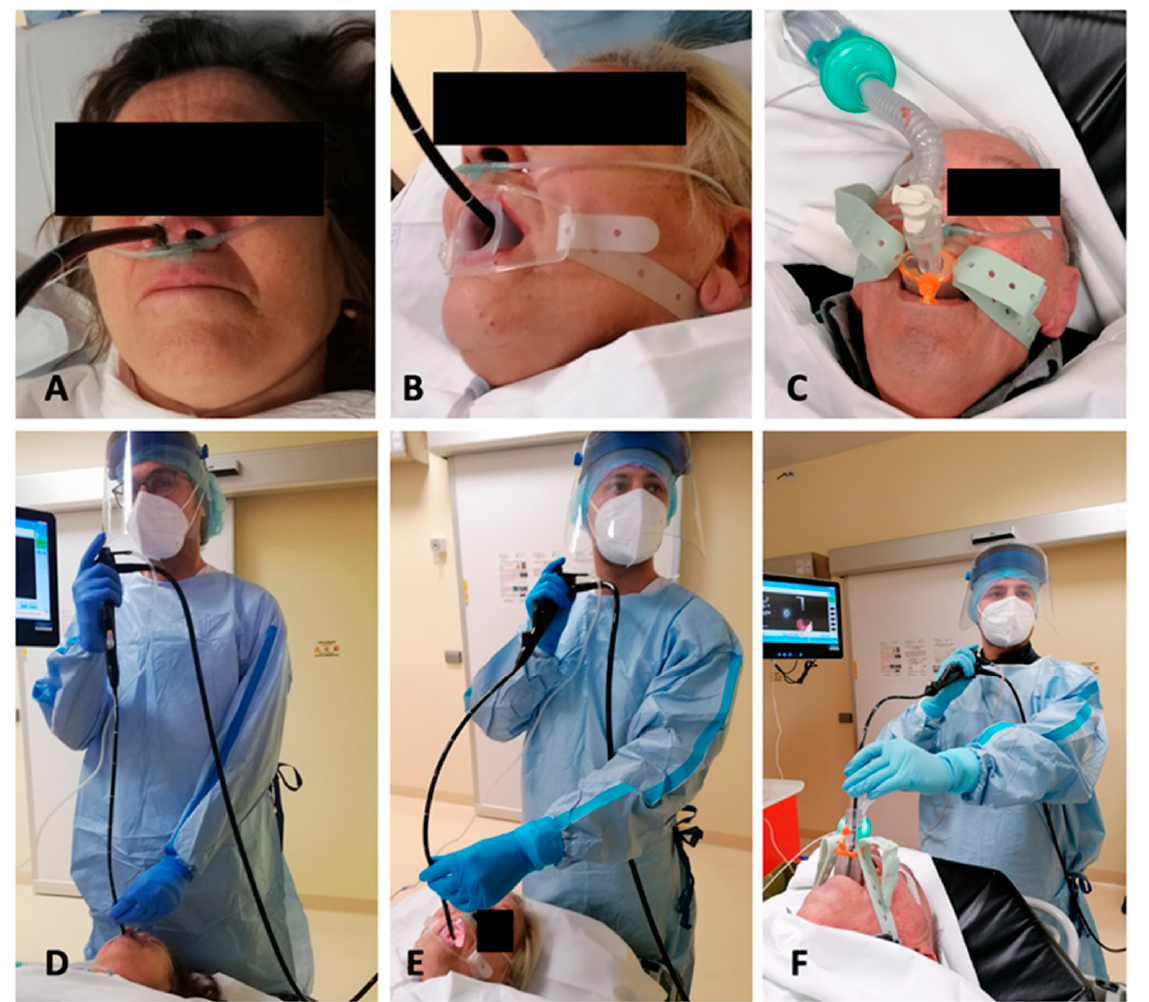
Figure 1. ( A – C ), entry ways of the EBUS scope: ( A ), nose; ( B ), mouth with mouthpiece; ( C ), laryngeal mask (i-gel). ( D – F ), endoscopist position in each of the entry ways: ( D ), nose; ( E ), mouth; ( F ), laryngeal mask. EBUS, endobronchial ultrasound.